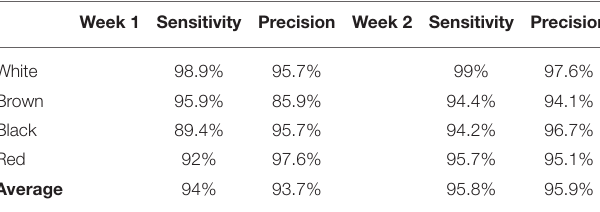
TABLE 3 | Sensitivity and precision of the animal identification